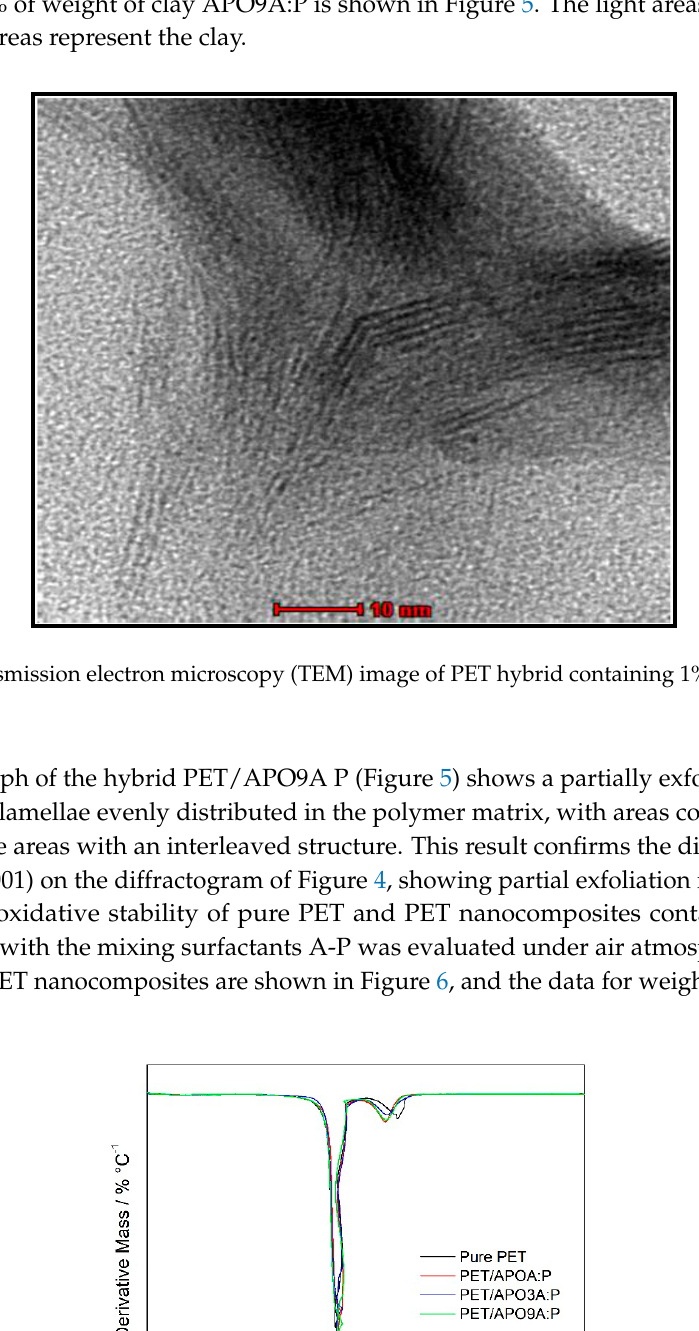
Figure 4. Diffractograms of PET hybrids with 1% by weight of modified AP clay with the mixture of surfactants A-P containing varying amounts of A and P: PET/APOA:P, PET/APO3A:P, and PET/APO9A:P.